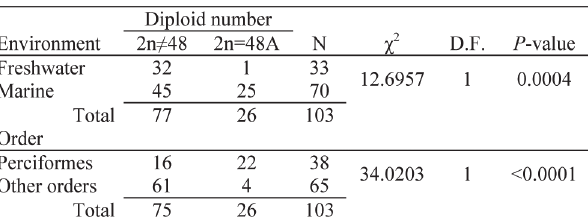
Table 3. Results of Chi-square ( χ 2 ) test between freshwater and marine environment and between Perciformes and other Orders. N = Number of